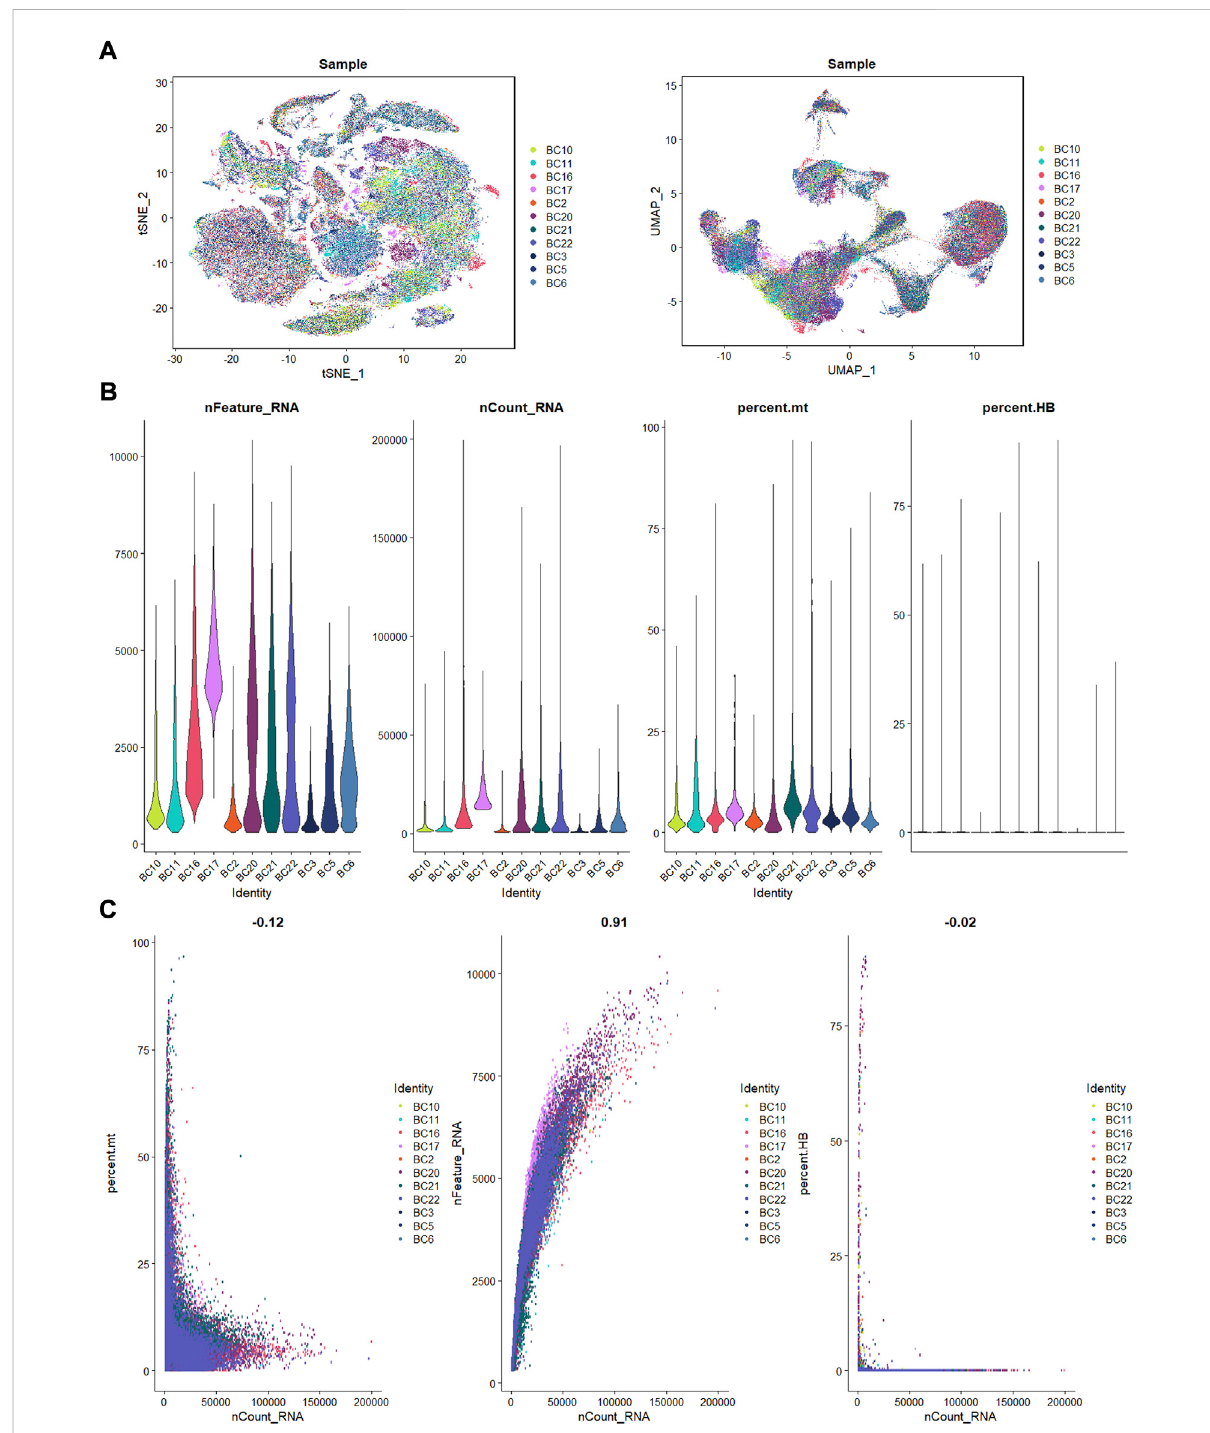
FIGURE 1 The process of quality control. (A) : t-SNE and UMAP plots after harmony. (B) : violin plots of feature, count, percent. mt, and percent.HB. (C) : correlation plots for count and feature, percent. mt, percent.